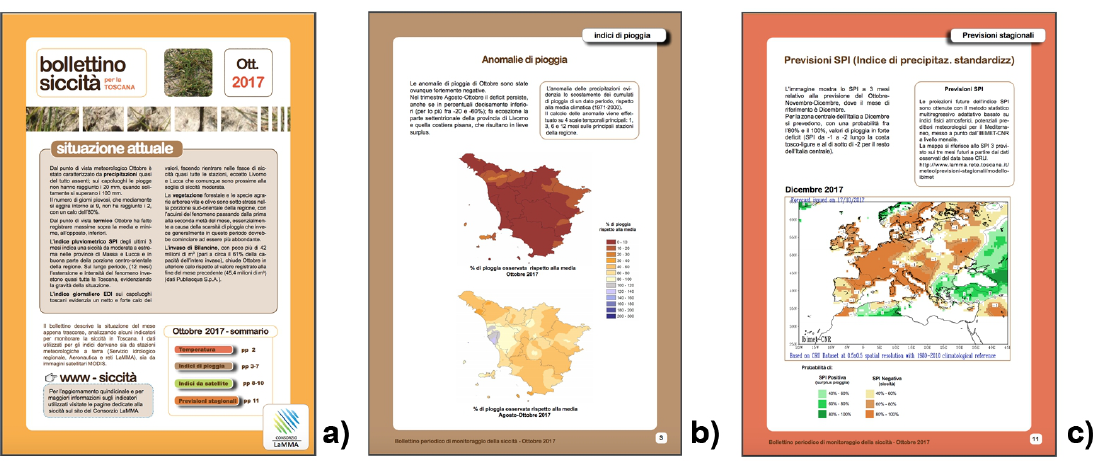
Figure 12. Some example pages of the monthly bulletin: ( a ) main page with a summary of all indices; ( b ) rainfall anomaly for the last month and the last 3 months; ( c ) SPI (Standardized Precipitation Index) forecast for the next